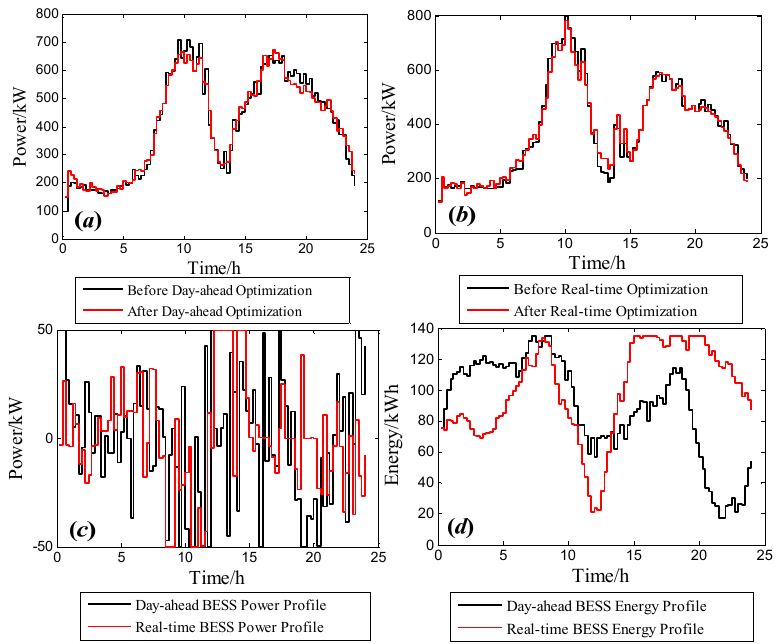
Figure 8. ( a ) Load profiles of before and after BESS day-ahead optimizing (without EVs); ( b ) load profiles of before and after BESS real-time optimizing (without EVs); ( c ) BESS operation power profiles of day-ahead and real-time (without EVs); ( d ) BESS operation energy profiles of day-ahead and real-time (without